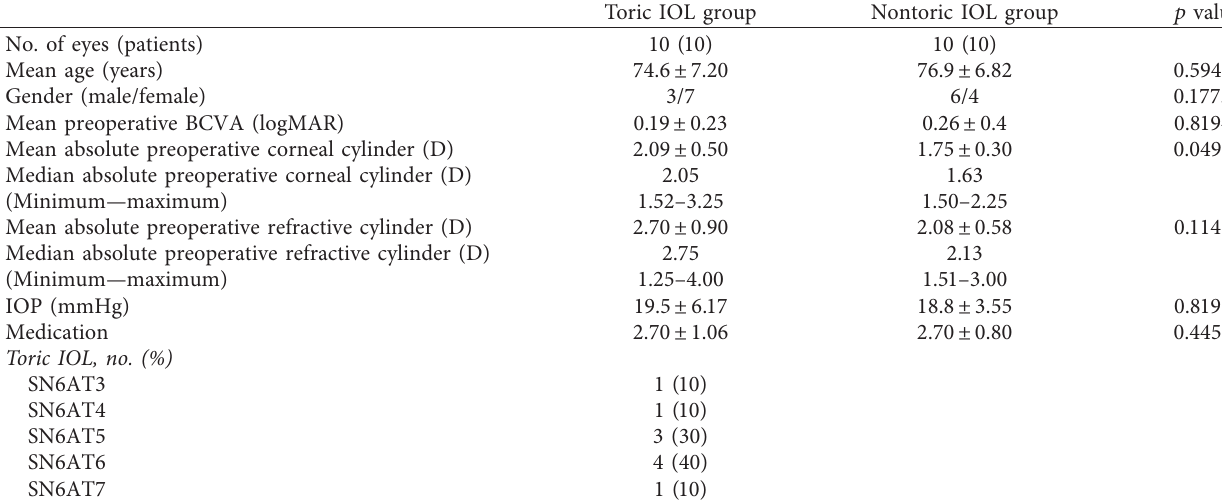
Table 1: Demographic and preoperative clinical data.